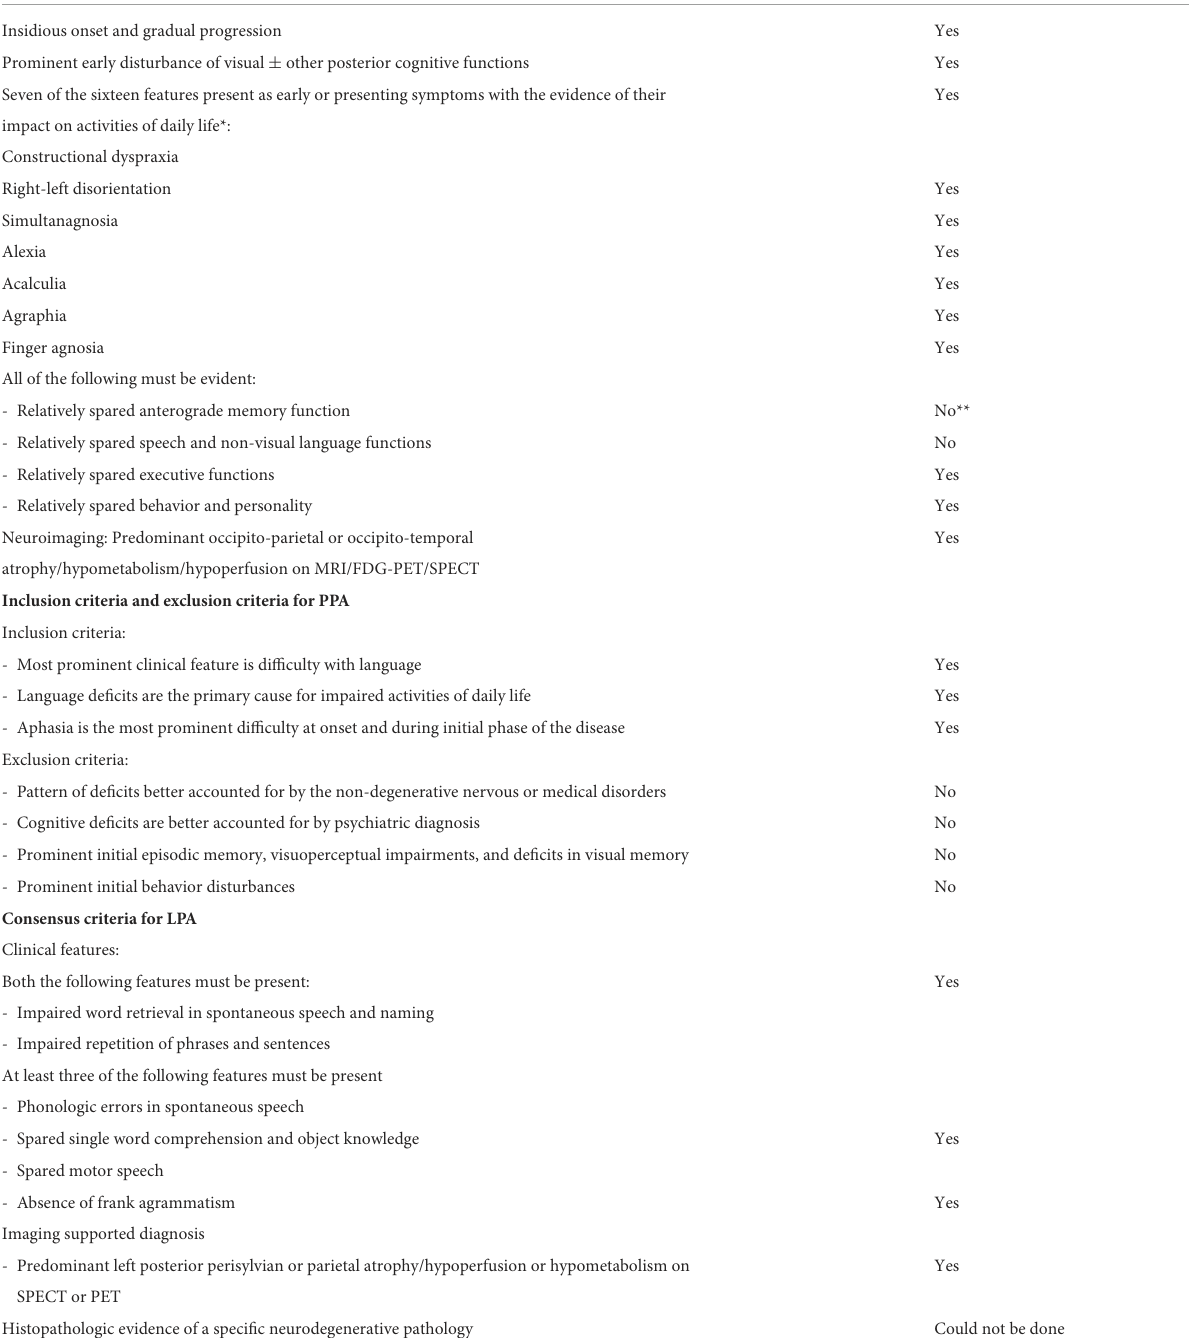
TABLE 1 Consensus criteria for pure-PCA, PPA, and LPA and the clinical, cognitive, and neuroimaging features of our patient. Consensus criteria for pure-PCA Features observed in the case Insidious onset and gradual